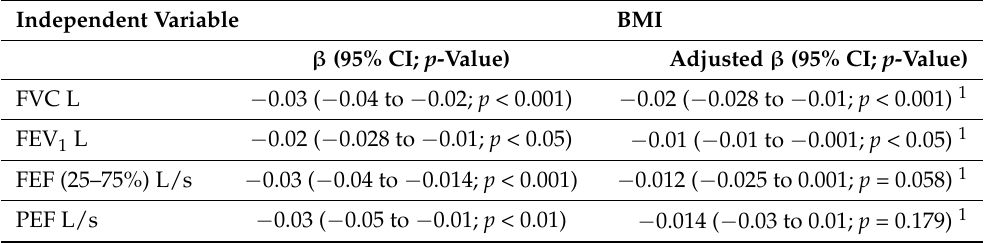
Table 2. Analysis of the associations of BMI with spirometry measures. Independent Variable